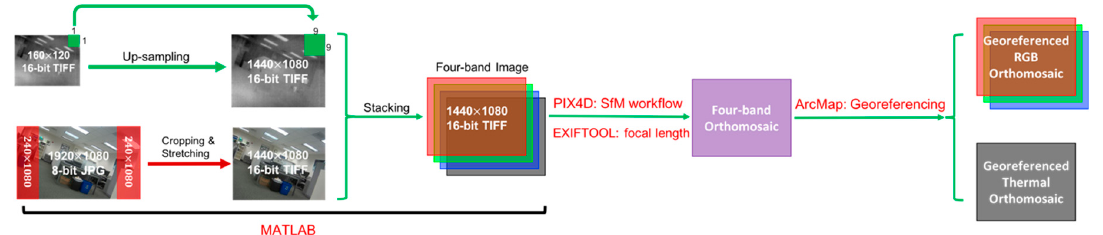
Figure 3. The workflow of pre-processing the UAV images, mosaicking, and post-processing the orthomosaics. A sample of office scene is used to demonstrate how the thermal image (in gray scale) is up-sampled and then stacked onto its corresponding RGB image, the latter of which have been cropped and radiometrically stretched. The four-band images are mosaicked by SfM workflow in PIX4D. The generated four-band orthomosaic is georeferenced by Esri’s Arcmap. The labels in red indicate the software required in the workflow.